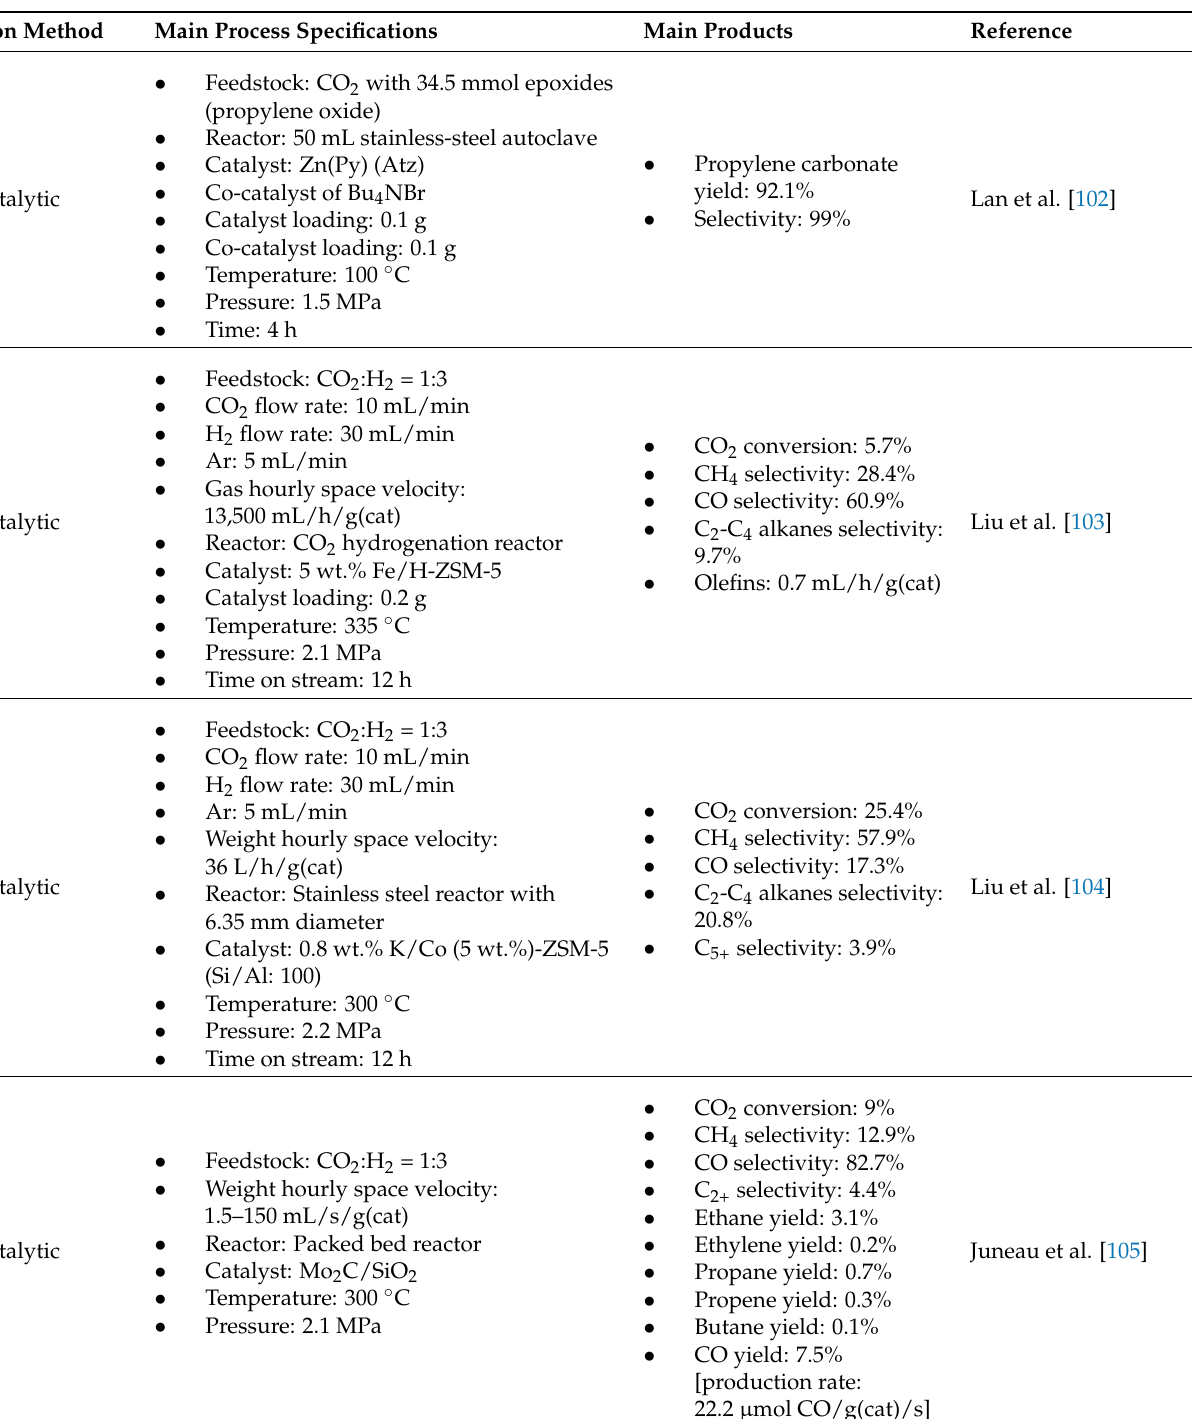
Table 2. Summary of promising studies on the conversion of CO 2 into chemicals and clean